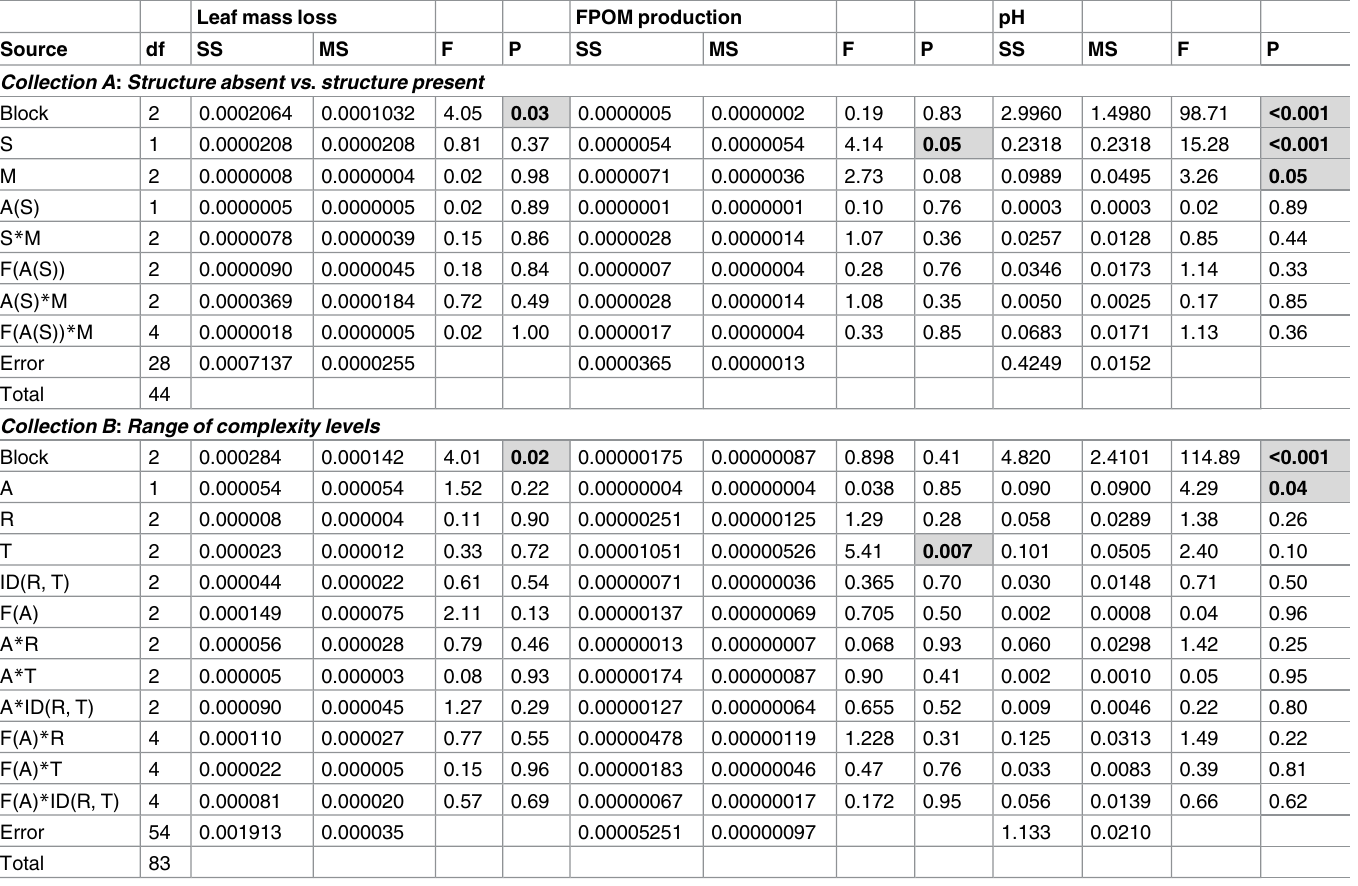
Table 2. Analysis of variancefor three response